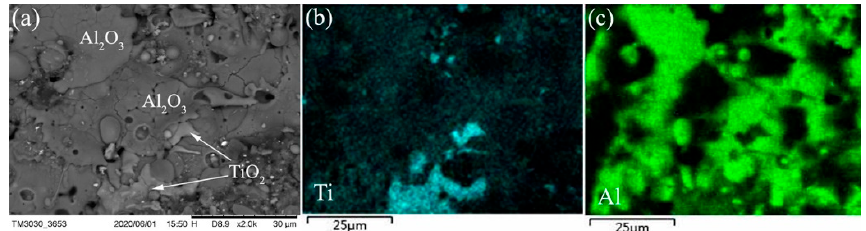
Figure 3. ( a ) Surface morphology and element mapping of ( b ) Ti and ( c ) Al of the AT13 coating prepared at the optimized parameters.